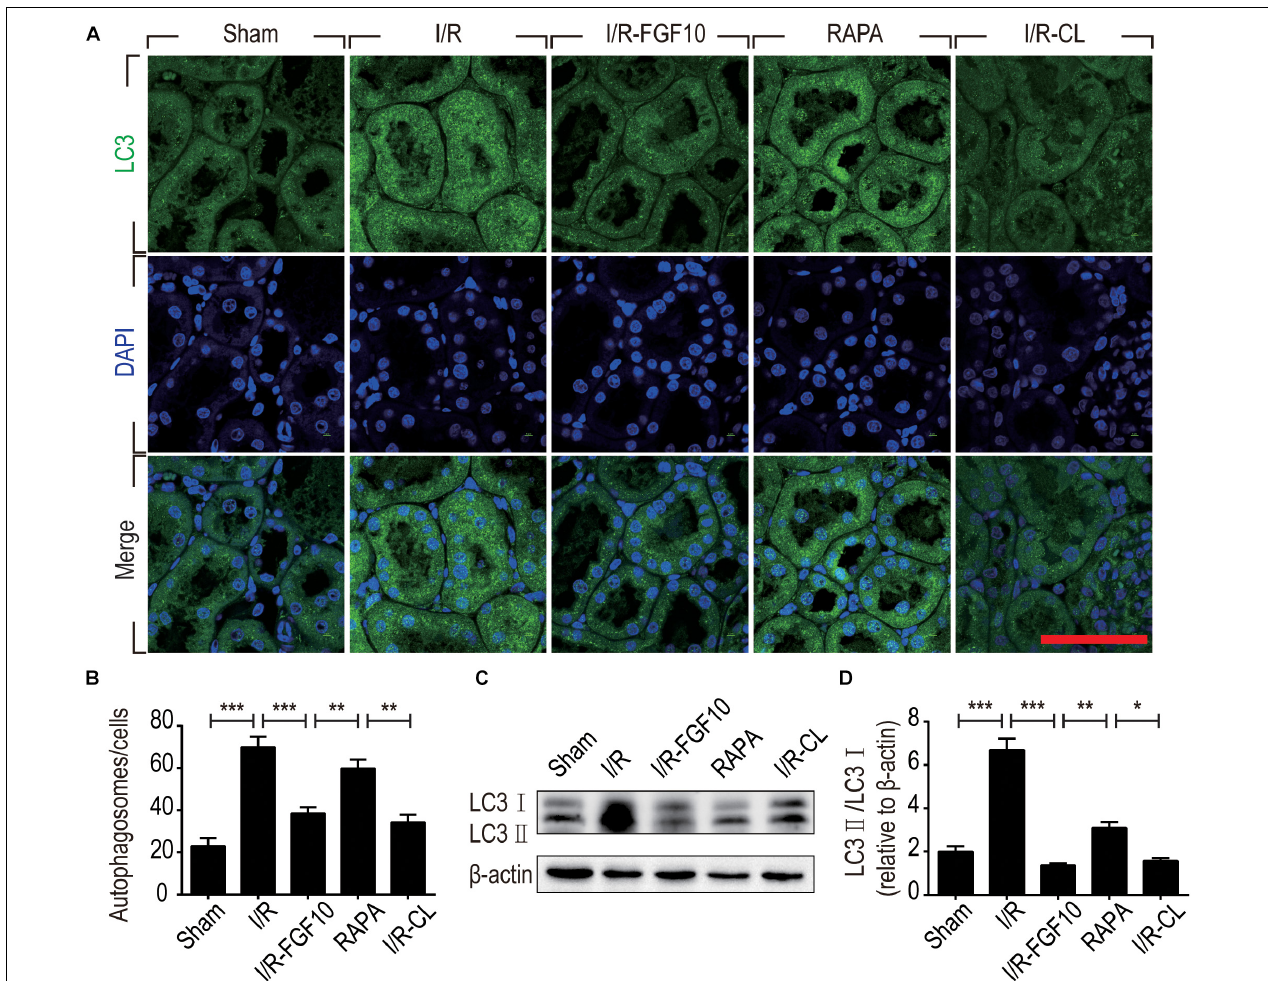
FIGURE 4 | FGF10 reduces the formation of autophagosome and the expression of LC3II. (A) Immunofluorescence staining of LC3 (green) was performed at 48 h after reperfusion. Nuclei were labeled with DAPI (blue). Scale bars = 50 µ m. (B) Statistic analysis of the number of autophagosomes in RTCs with 5 randomly selected images in each group. (C) The protein expression of LC3II/LC3I in renal tissue was determined by Western blot and the optical densities were quantified (D) . Data are presented as the mean ± SEM ( n = 5). ∗ P < 0.05, ∗∗ P < 0.01, ∗∗∗ P < 0.001.